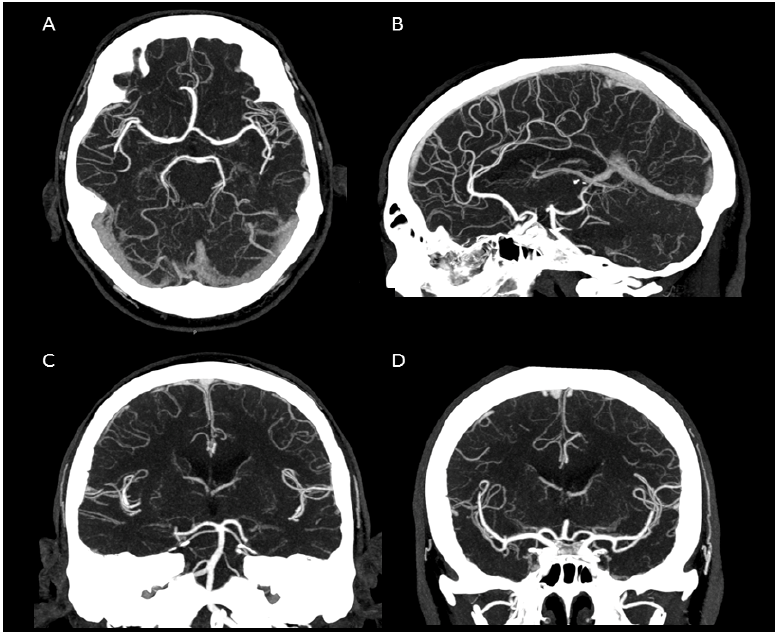
Figure 3. Maximum intensity projection of an intracranial UHR-CTA. ( A ) axial plane. ( B ) sagittal plane. ( C , D ) coronal plane. Note the clear traceability/visualization of the circle of Willis and even the small peripheral vessel branches.